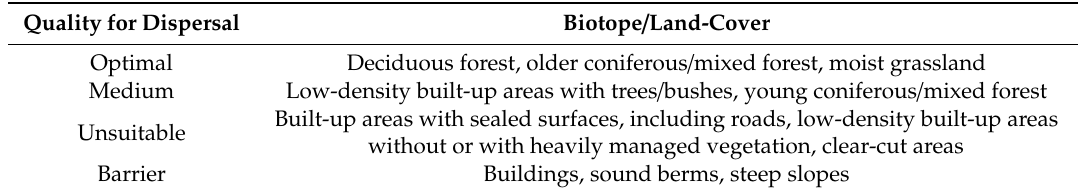
Table A3. Dispersal profile for the common toad according to Mörtberg et al.